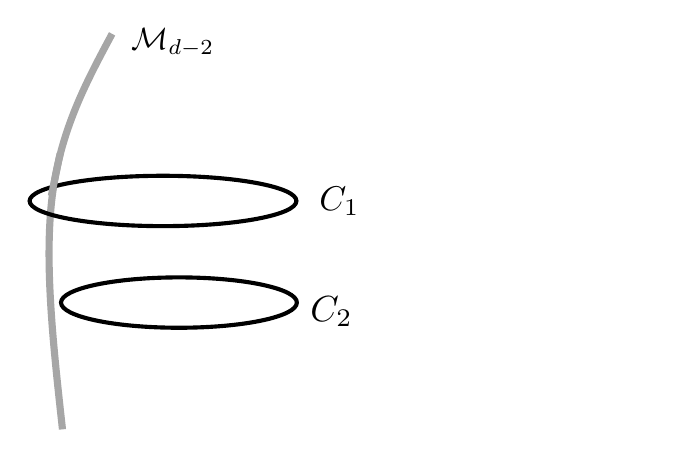
links the charge operator 1